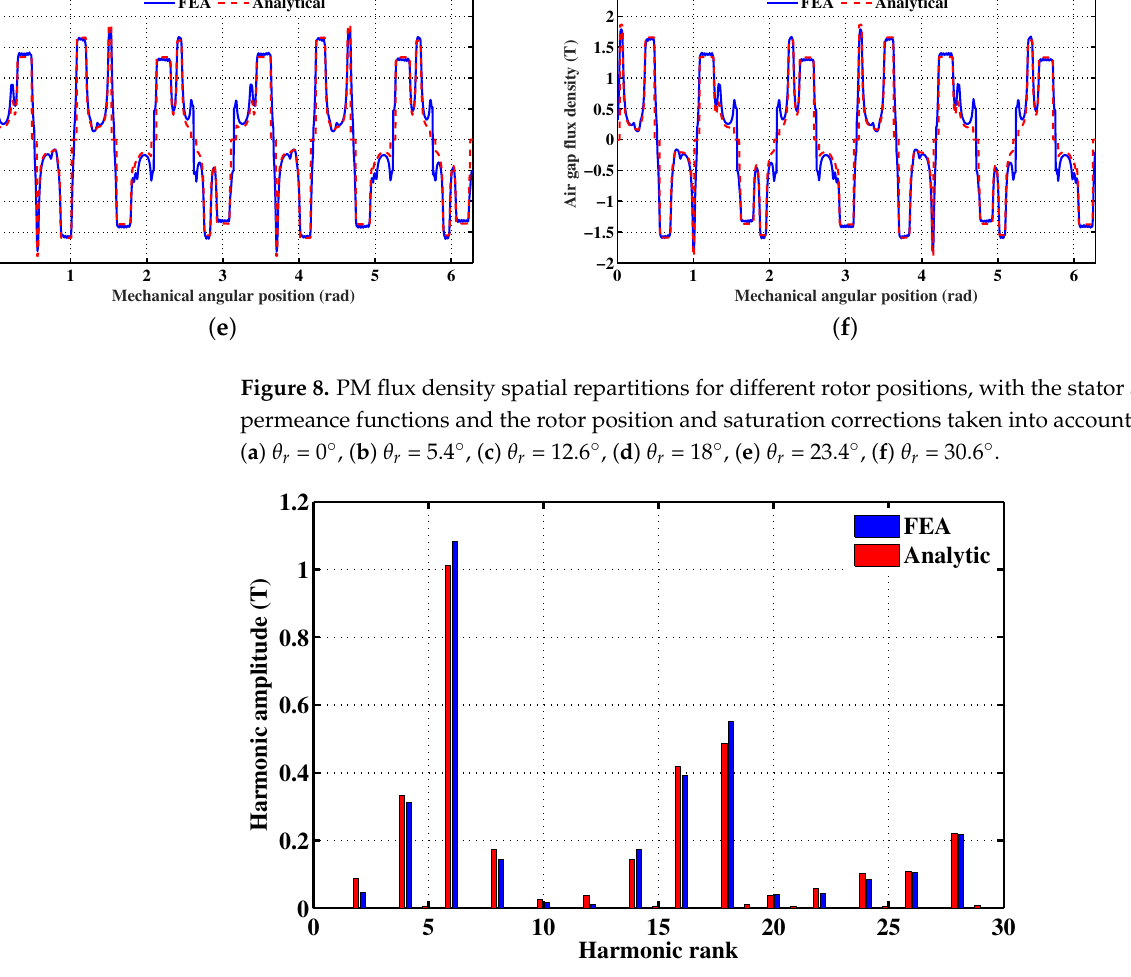
Figure 9. Spectra corresponding to the FFT of the analytically- and FEA-predicted B PM ( θ ) shown in Figure